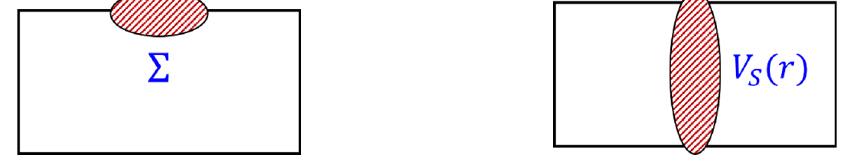
Figure 1 . Schematic representations of diagrams contributing to (cid:6) and V S ( r